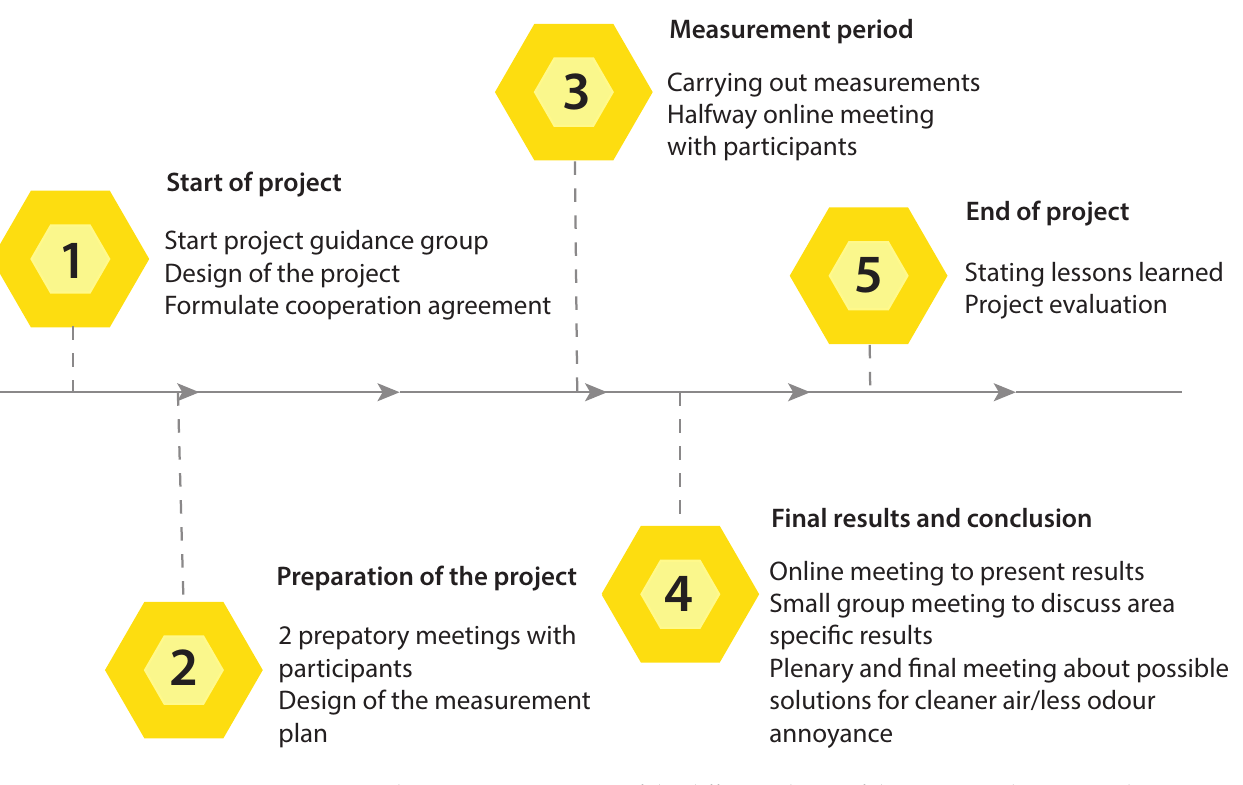
Figure 1. Schematic representation of the different phases of the project and corresponding